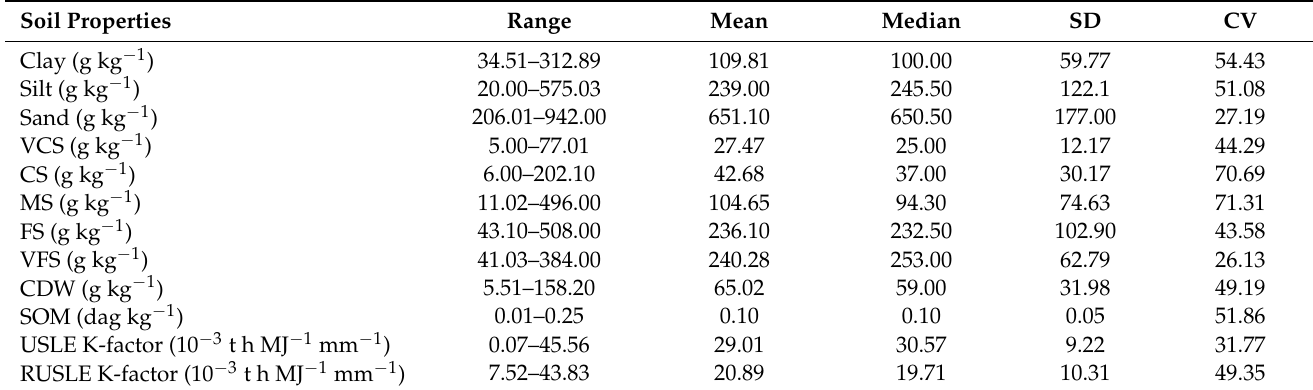
Table 1. Descriptive statistics of soil properties (n = 80).